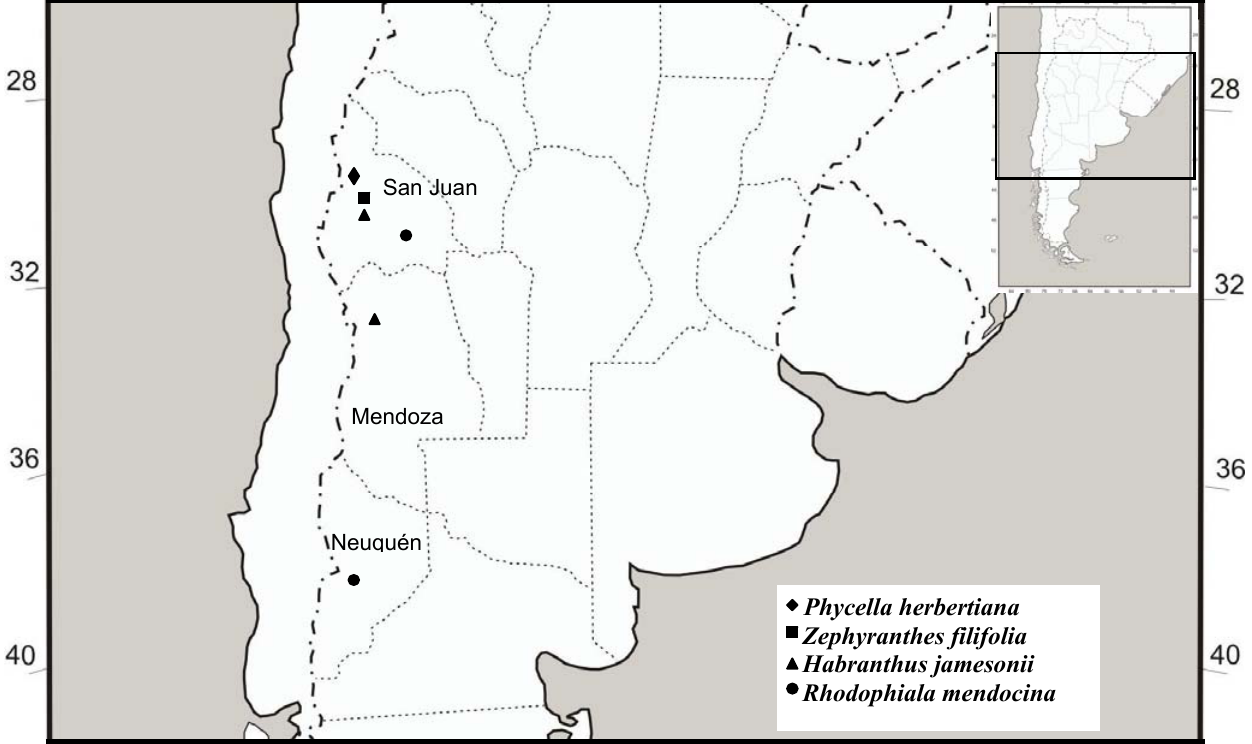
Figure 4. Collection areas of Argentinian wild